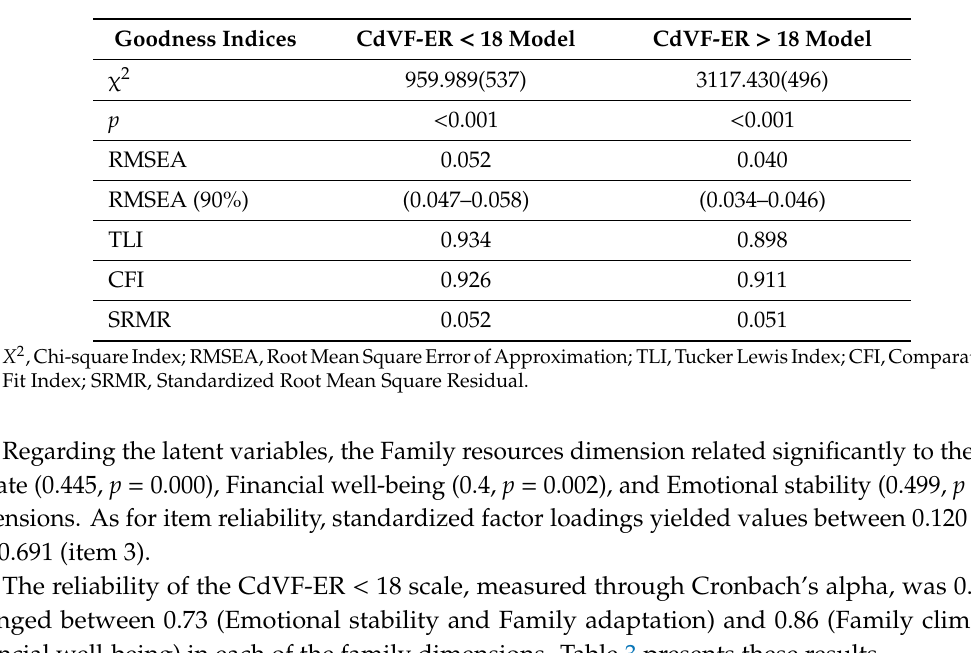
Table 2. Goodness of fit indices for the final model of the CdVF-ER < 18 and CdVF-ER > 18 scales.